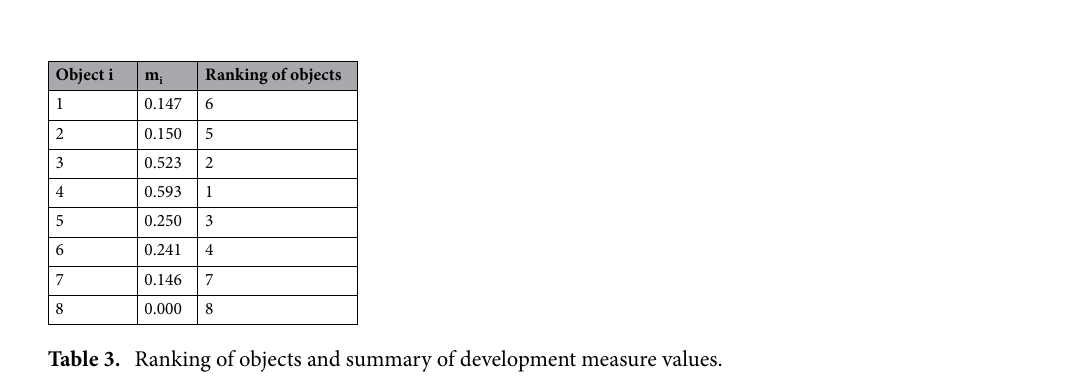
Table 2. Ranking of objects and summary of development measure values.